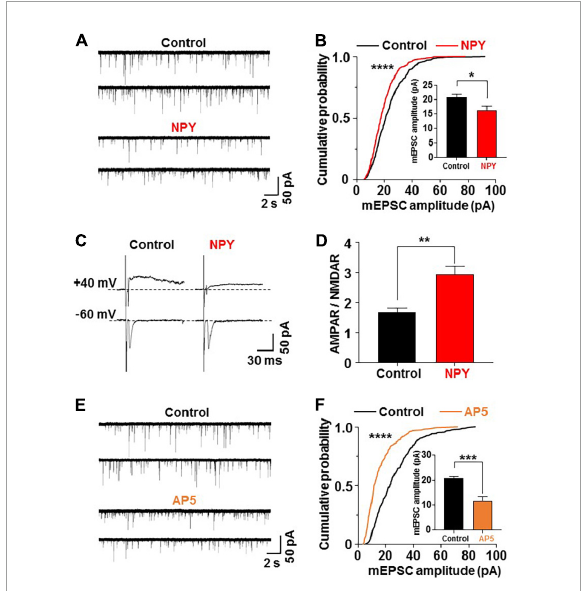
FIGURE3 Neuropeptide Y (NPY) depresses miniature excitatory postsynaptic current (mEPSC) by inhibiting N -methyl- D -aspartic acid type glutamate receptor (NMDAR). Hypothalamic slices from oxytocin (OXT) mRFP rats were pretreated for 3 h without (control) and with NPY (10 – 8 M) or the NMDAR antagonist AP5 (50 µ M). Subsequently, paraventricular nucleus (PVN) OXT neurons were subjected to whole-cell patch-clamp recording. Upper and lower traces of mEPSC in each condition show results from two distinct OXT neurons. (A,B) Representative traces of mEPSC (A) , cumulative probability distribution of mEPSC amplitudes (B) and average amplitude of mEPSC